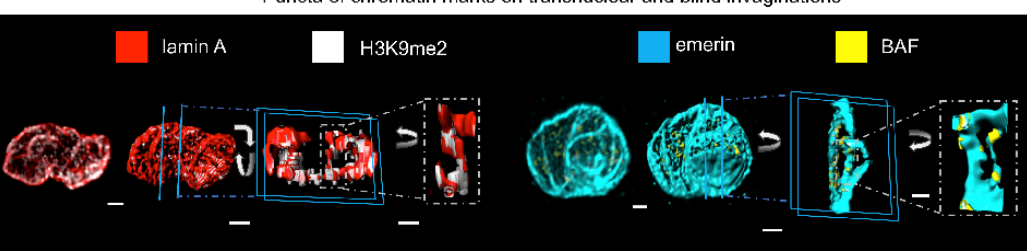
Figure 15. Right hand panels, sections through a 3D reconstruction of the nucleus of a pulmonary arterial myocyte reveal puncta of lamin A and H3K9me2 colocalisation on a lamin A positive transnuclear invagination (from left to right scale bars 1 μ m, 1 μ m, 500nm). Left hand panels, sections similarly show puncta of emerin and BAF (barrier to autointegration factor) colocalisation on transnuclear and blind invaginations (from left to right scale bars 1 μ m, 1 μ m, 500nm).